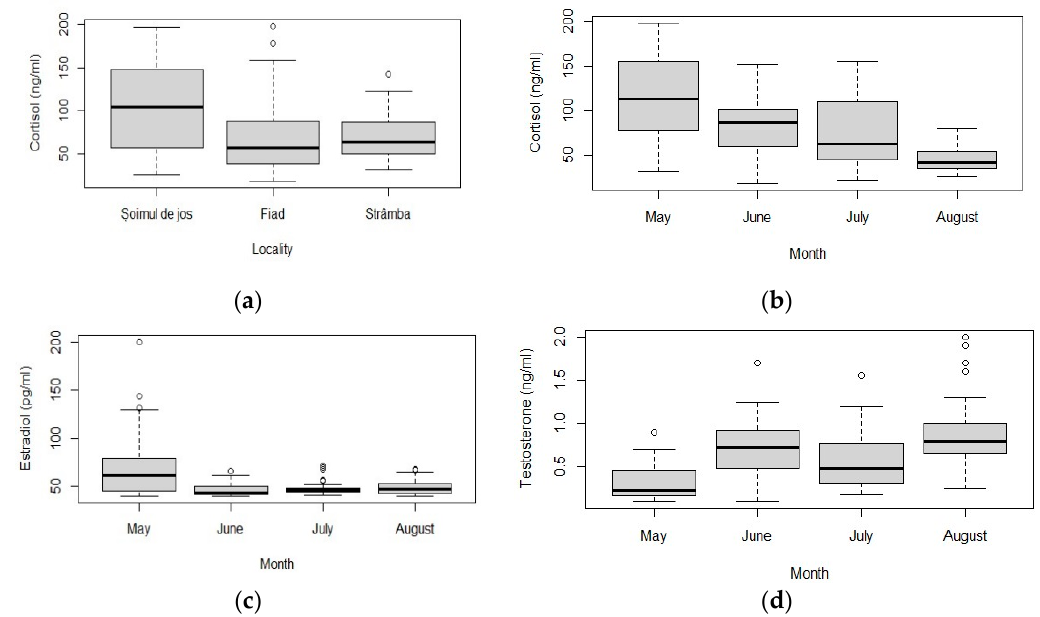
Figure 5. Hormonal profile of rainbow trout ( Oncorhynchus mykiss ): ( a ) F values measured in all months in different farms; ( b ) F values measured in all farms in different months; ( c ) E 2 values measured in all farms in different months; ( d ) T values measured in all farms in different months. Plots represent median (line inside boxes) values, 25–75 percent quartiles (boxes), and minimal and maximal values, shown with short horizontal lines (“whiskers”). Outliers are represented with an open circle sign.